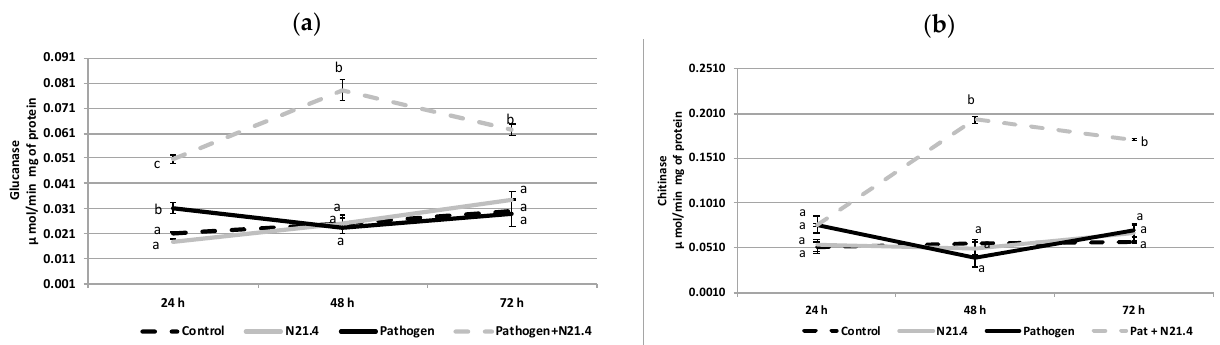
Figure 6. Activity of PR enzymes of 6-week old tomato plants inoculated with P. fluorescens N21.4 and non-inoculated controls in the priming phase and in the post-challenged priming state after inoculation with the leaf spot pathogen Xanthomonas campestris at 24 h, 48 h and 72 h after challenge. ( a ) ß-1,3-Glucanase (PR2). ( b ) Chitinase (PR3). Control: non treated nor challenged plants (black broken line). N21.4: plants treated with Pseudomonas fluorescens (grey solid line). Pathogen: plants challenged with the leaf spot pathogen Xanthomonas campestris (black solid line). Pathogen + N21.4: plants treated with Pseudomonas fluorescens N21.4 and challenged with the leaf spot pathogen Xanthomonas campestris (grey broken line). Bars indicate standard errors; different letters indicate significant differences ( p < 0.05) between treatments for each time point.